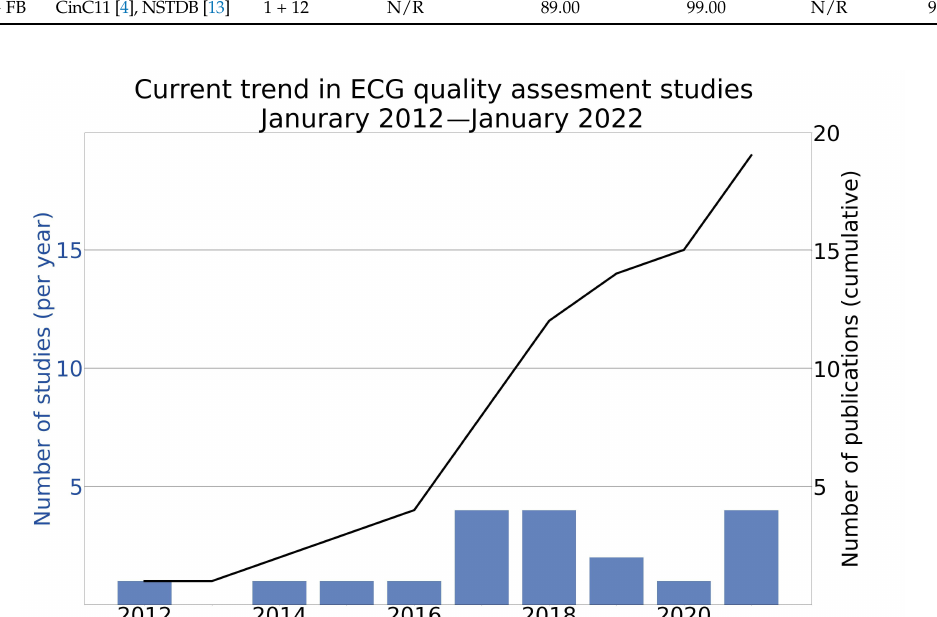
Figure 2. Cumulative sum of the publications and the total number of studies that addressed automatic ECG quality assessment techniques from January 2012 to January